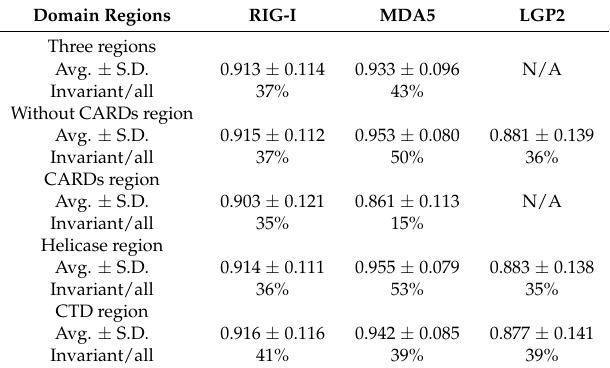
Table 1. Conservation scores of the three avian RIG-I-like receptors (retinoic acid-inducible gene-I-like receptors, or RLRs).